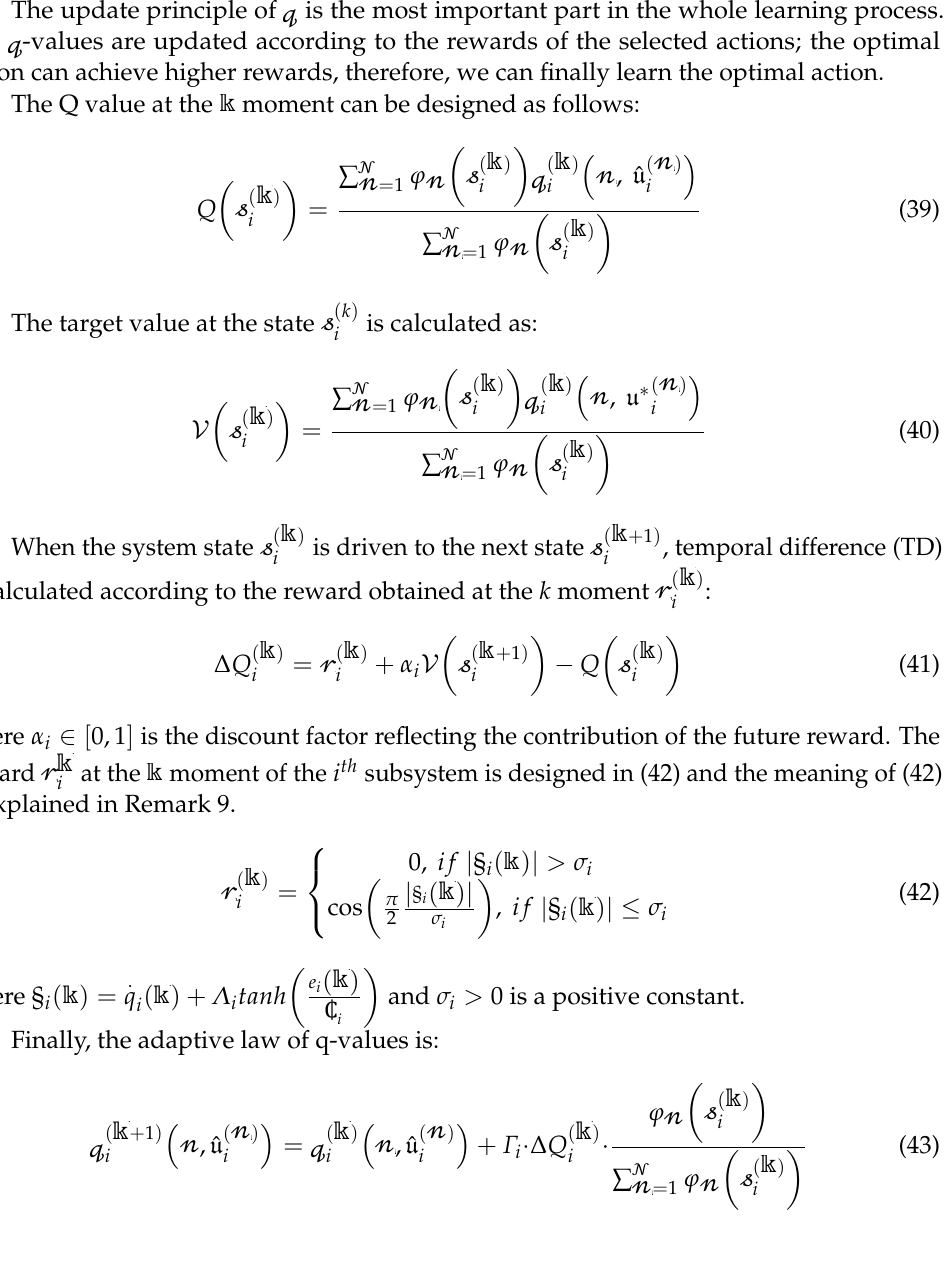
Figure 2. Membership function of fuzzy input of the 𝑖 (cid:3047)(cid:3035) subsystem.